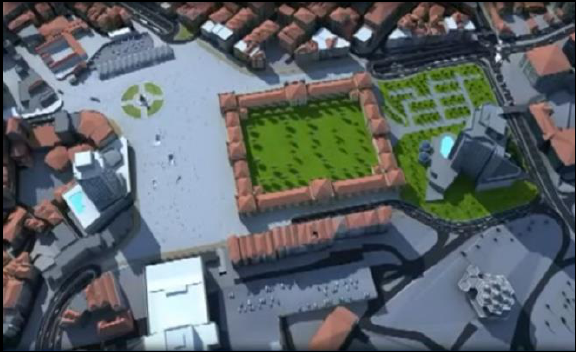
Figure 6. A scene from the video of Istanbul